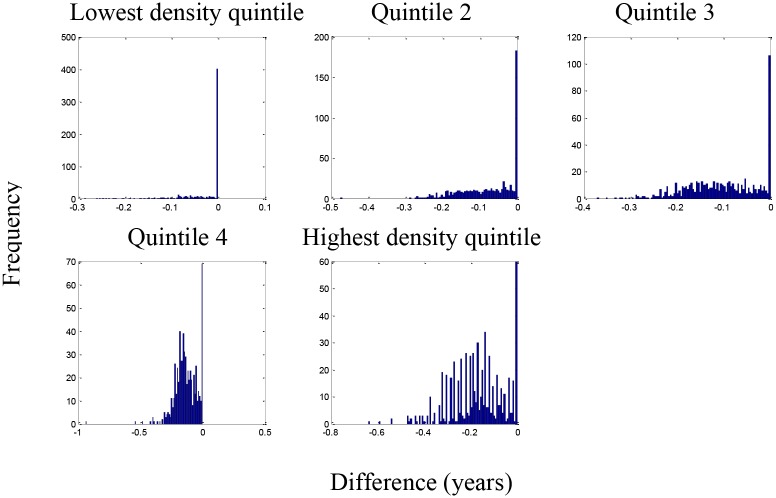
Change in life expectancy (years lost) resulting from being above the national 25th percentile for each pollutant.